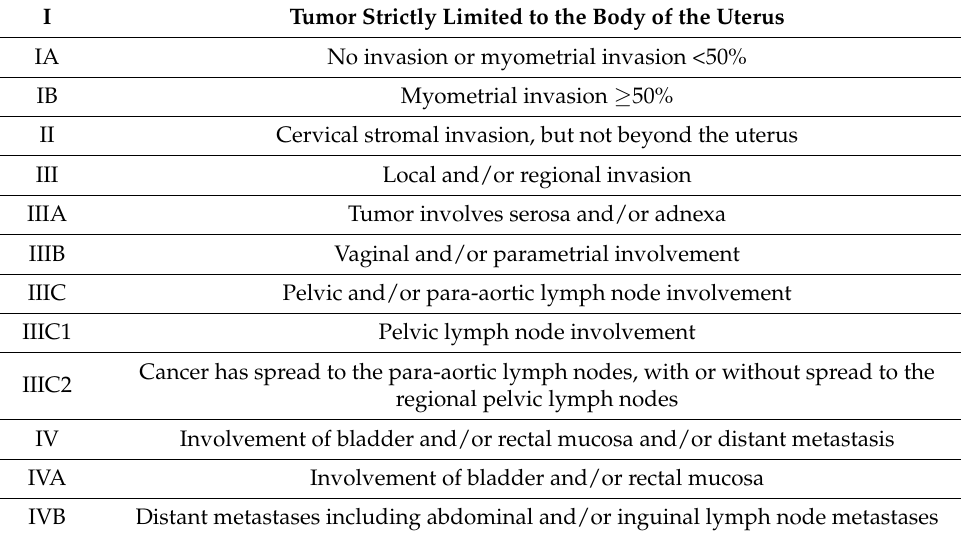
Table 1. System of endometrioid endometrial cancer classification according to FIGO from